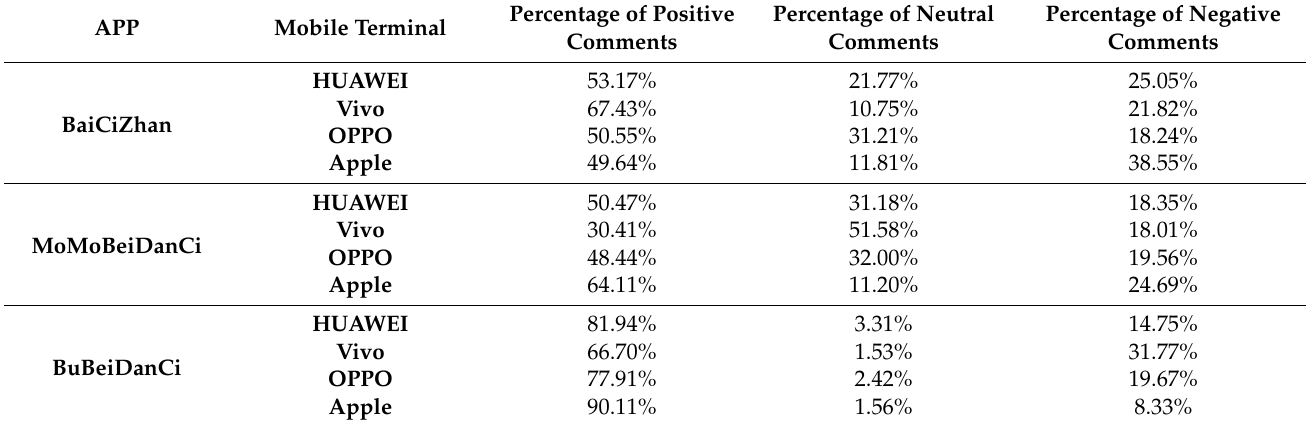
Table 2. The proportion of positive, neutral and negative comments of the three English vocabulary